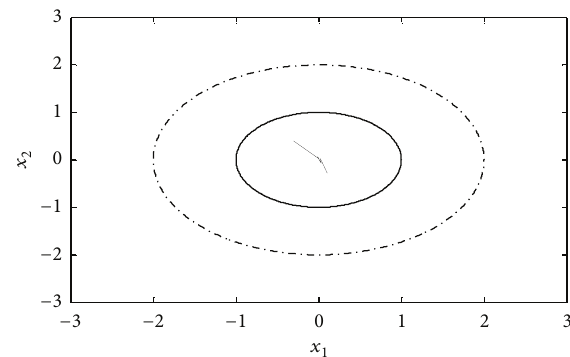
Figure 3: State trajectory under finite-time